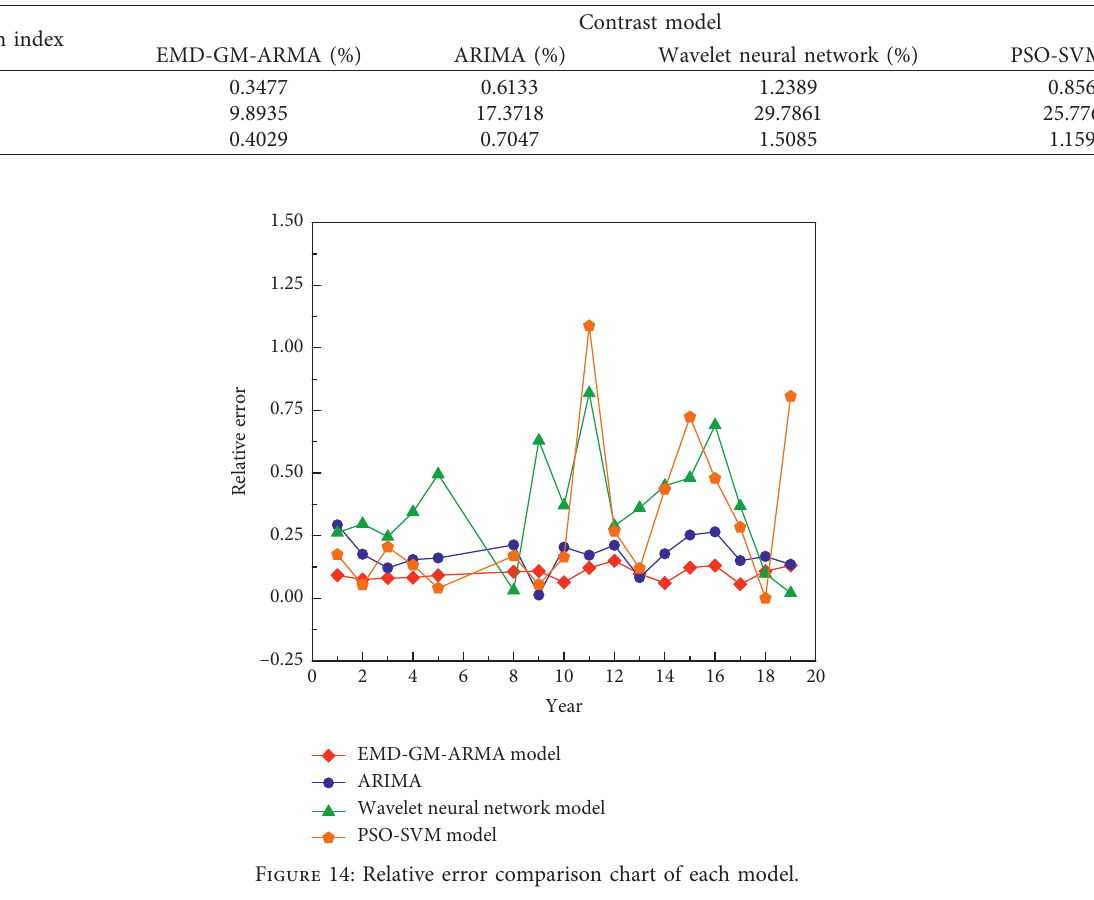
Table 4: Prediction error